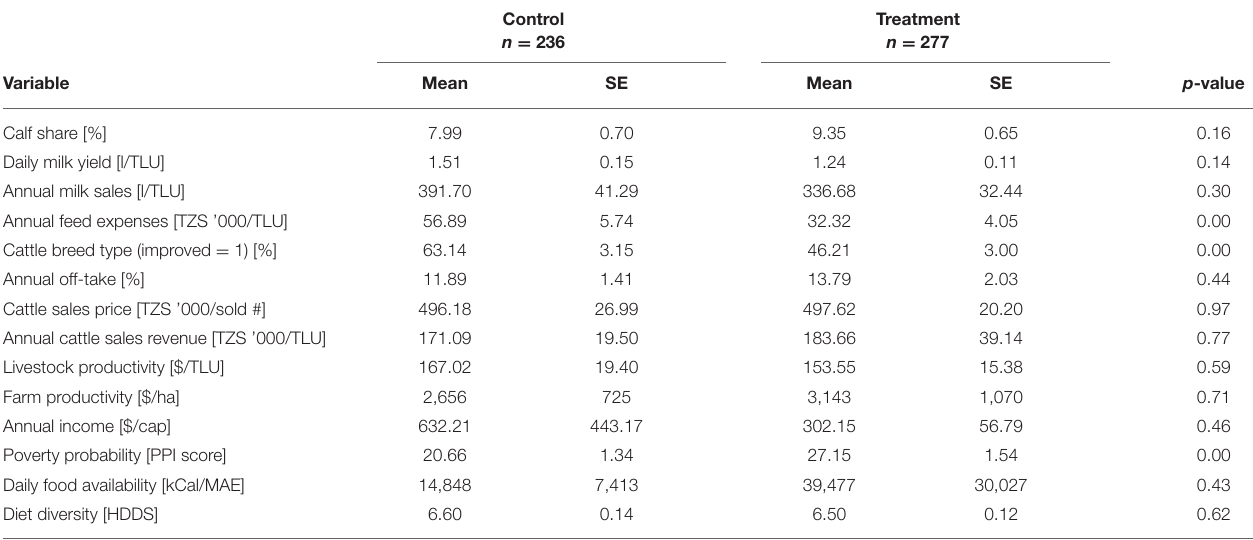
TABLE 2 | Descriptive statistics of dependent variables for ITM treatment and control groups.